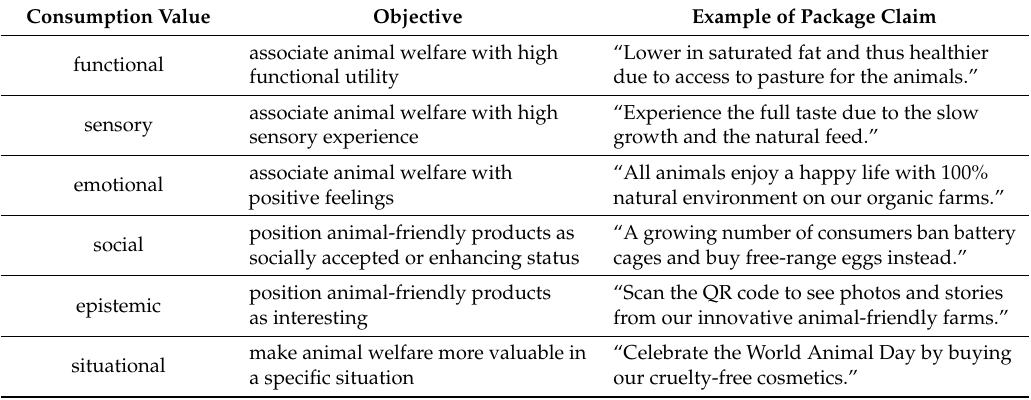
Table 1. Examples of package claims for reinforcement positioning strategies for animal-friendly